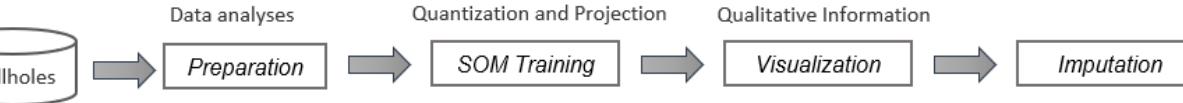
Figure 3. Schematic of SOM data mining attributes adapted from Friedel [30].